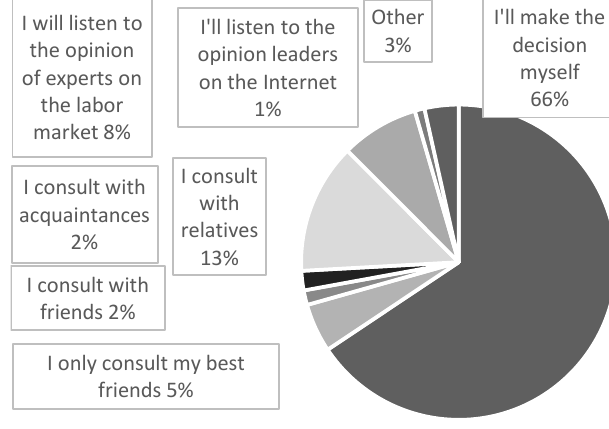
Figure. 4. Choosing a future career